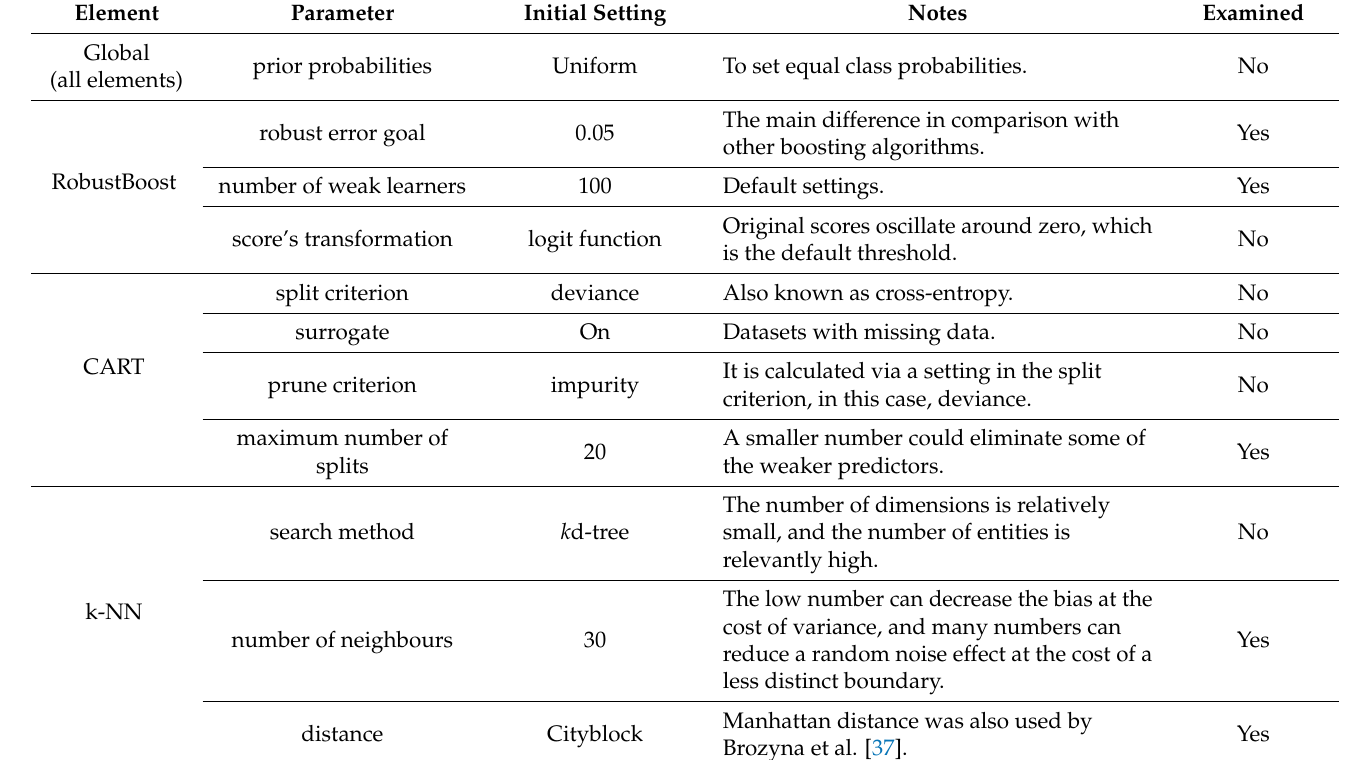
Table 5. Element’s